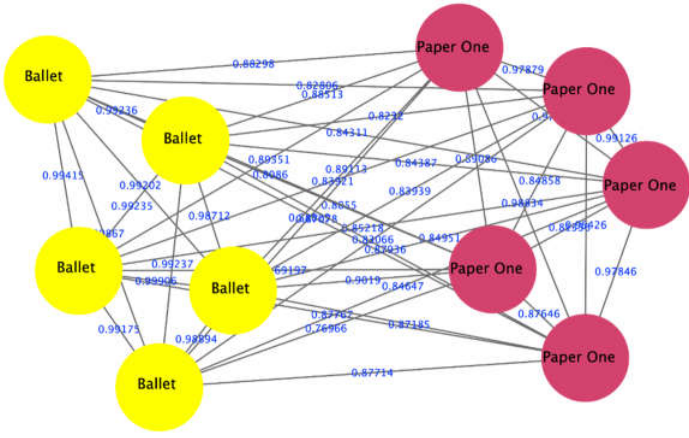
Figure 6. The proposed approach distinguished between two types of papers: PaperOne (red nodes) and Ballet (yellow nodes), which appeared in two separate clusters.